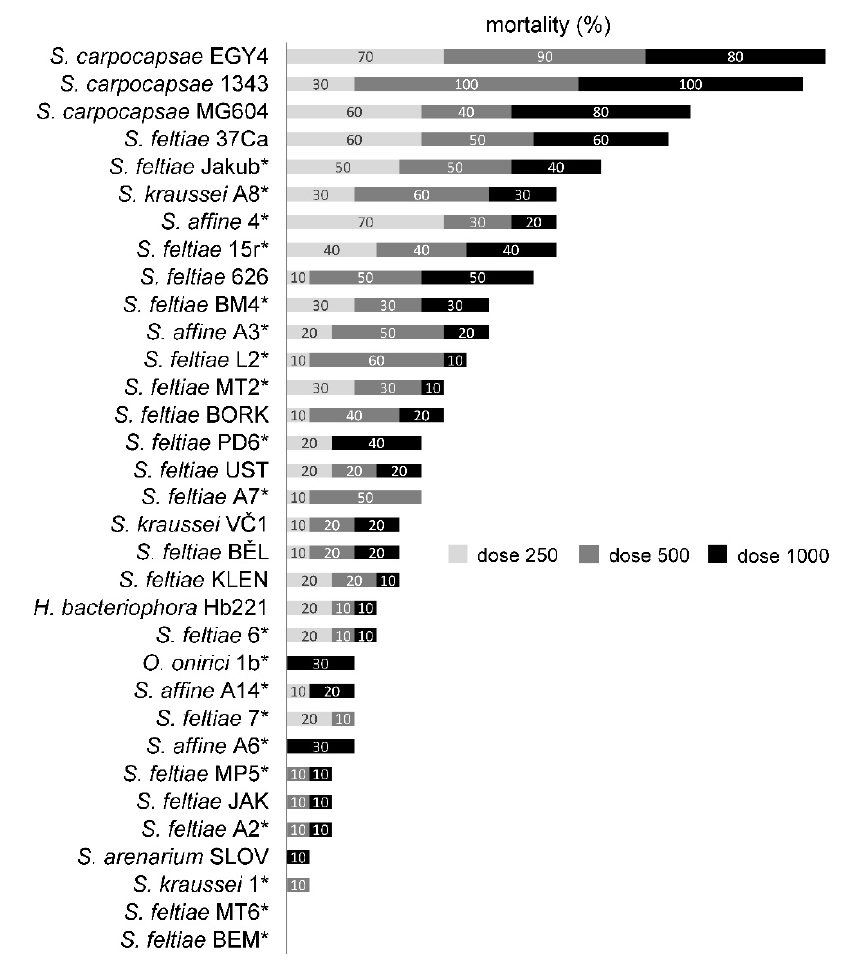
Figure 3. Percentage mortality of adult Colorado potato beetles caused by various EPN species and strains applied at three doses of 250, 500, and 1000 IJs per host. Endemic strains isolated within this study are marked (*).